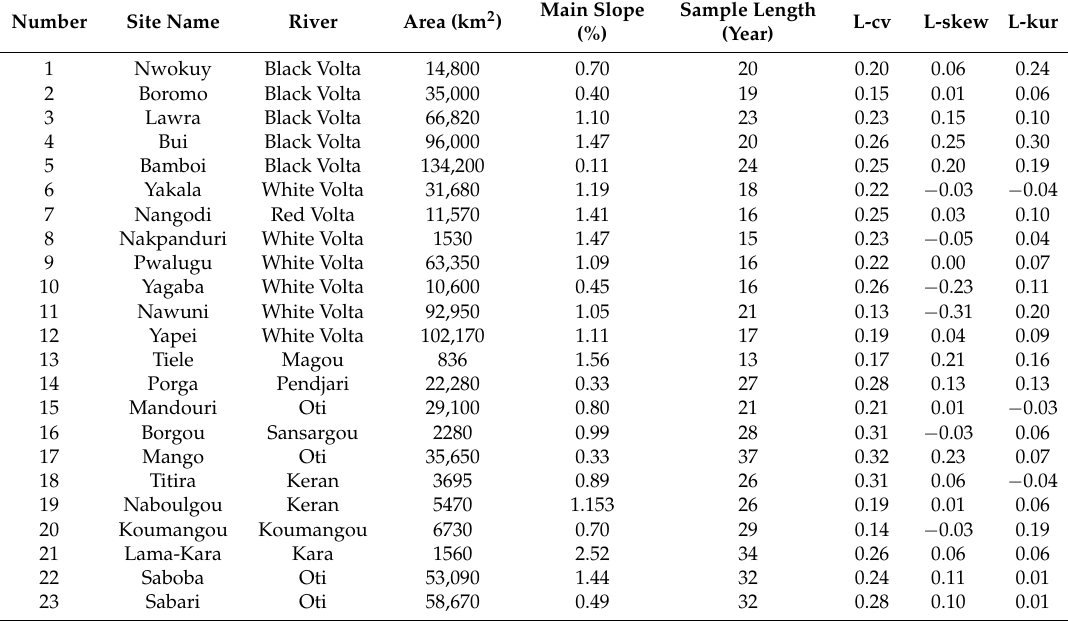
Table 3. Site characteristics used in the RFFA. L-cv, L-coefficient of variation; L-kur, L-coefficient of